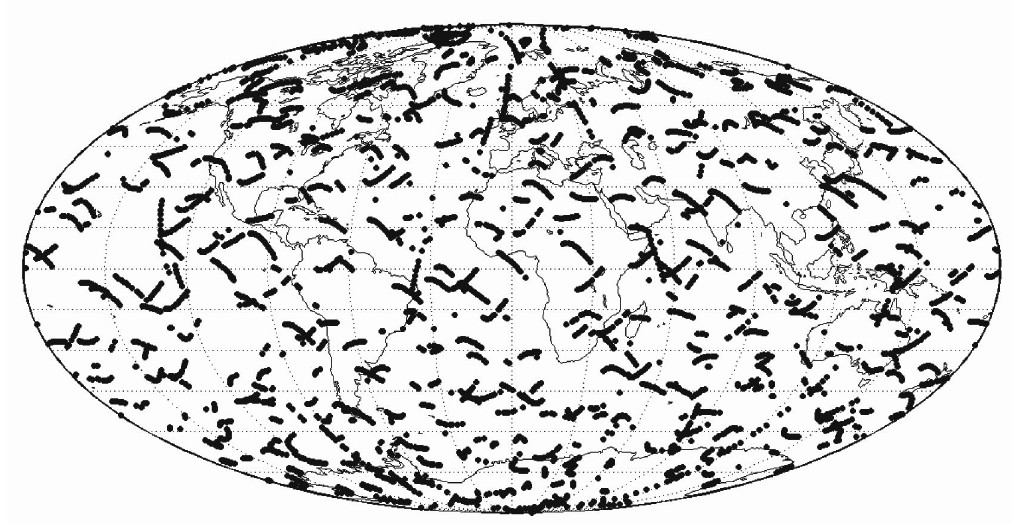
Fig. 7.2. Ionospheric radio occultation data coverage of CHAMP measurements during April